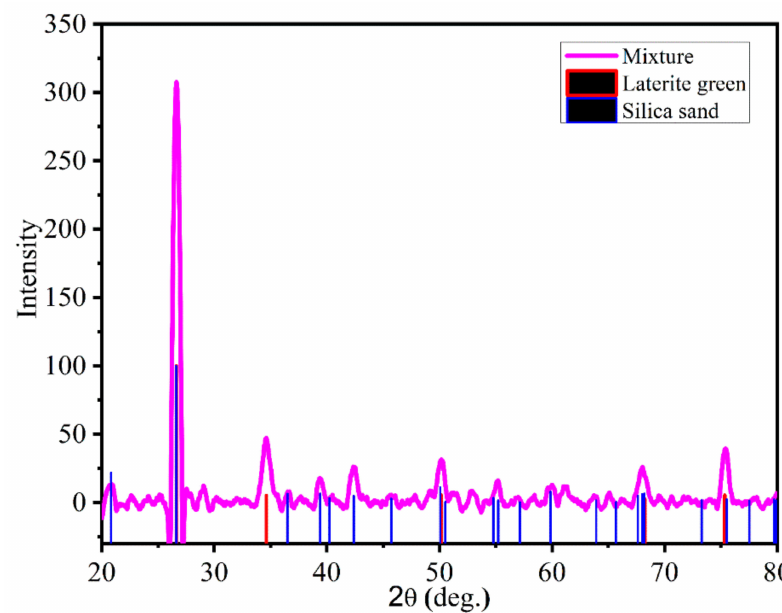
Figure 17. X-ray Diffraction (XRD) of laterite green and silica